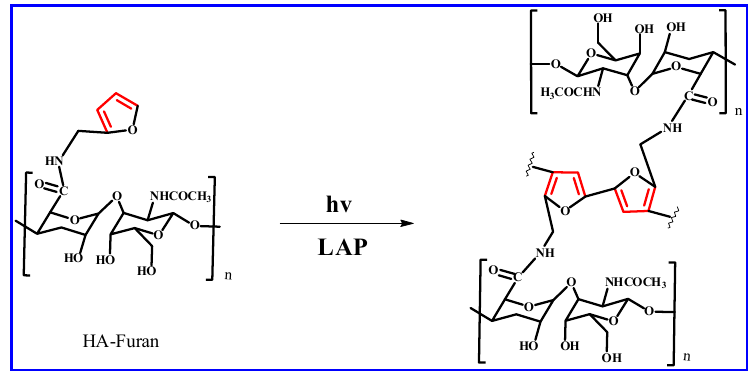
Scheme 3. Photo-crosslinking reaction of HA-Furan with LAP.